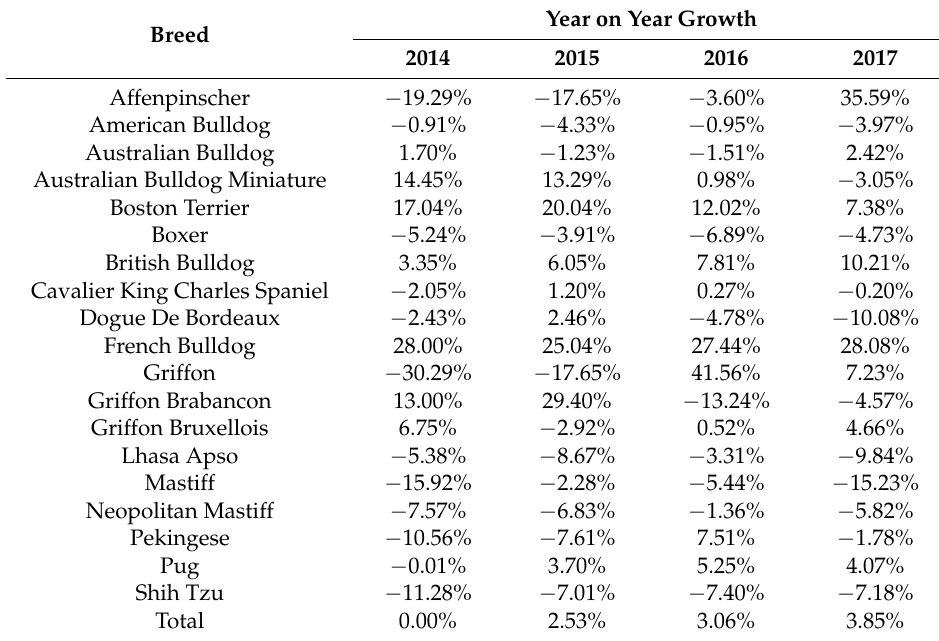
Table 1. Annual percentage changes in popular breeds insured by PetSure Australia. These numbers represent the growth for each breed as a proportion of all policies in force for each calendar